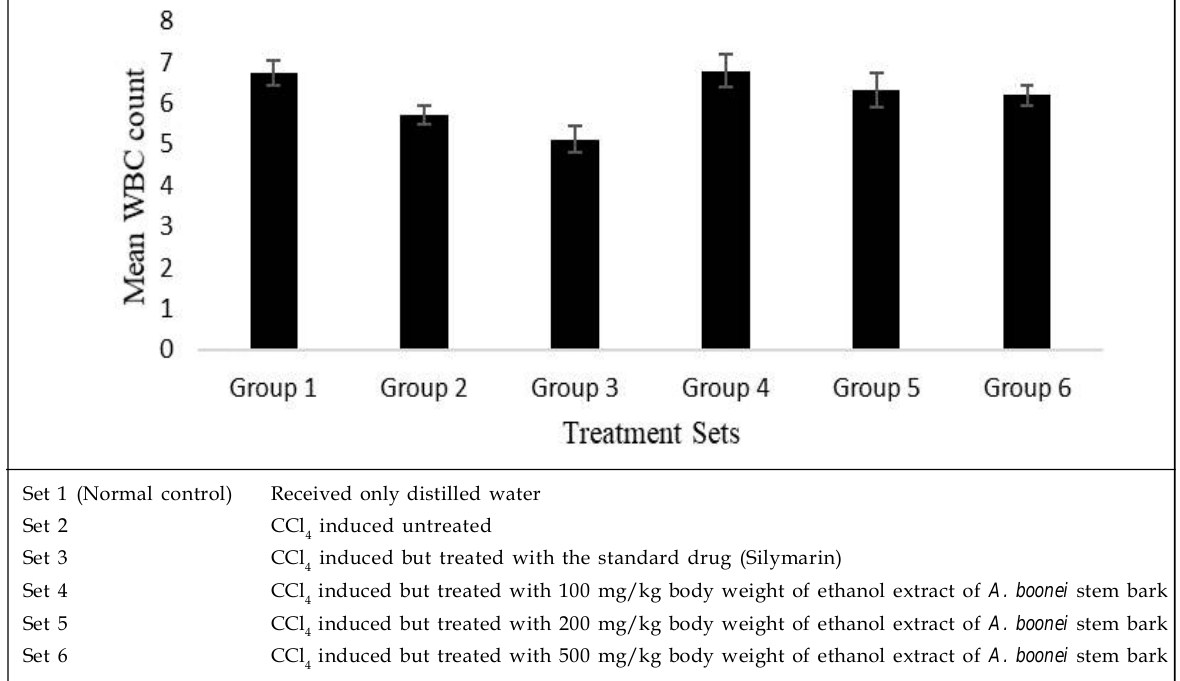
Figure 7: WBC count of male Wistar albino rats administered ethanol extract of A. boonei stem bark extract